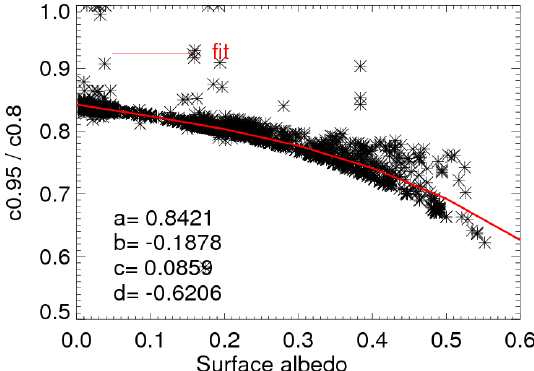
Fig. 2. Ratio of the effective cloud fractions retrieved with cloud albedo of 0.95 ( c 0 . 95 ) and cloud albedo of 0.8 ( c 0 . 8 ) as a func- tion of surface albedo (black stars) and the 3rd-order polynomial fit y = a + bx + cx 2 + dx 3 (red line). The effective cloud fractions are re- trieved from the SCIAMACHY orbit over Europe, the Sahara desert and the Atlantic Ocean on 4 February 2007 (orbit number 25785).